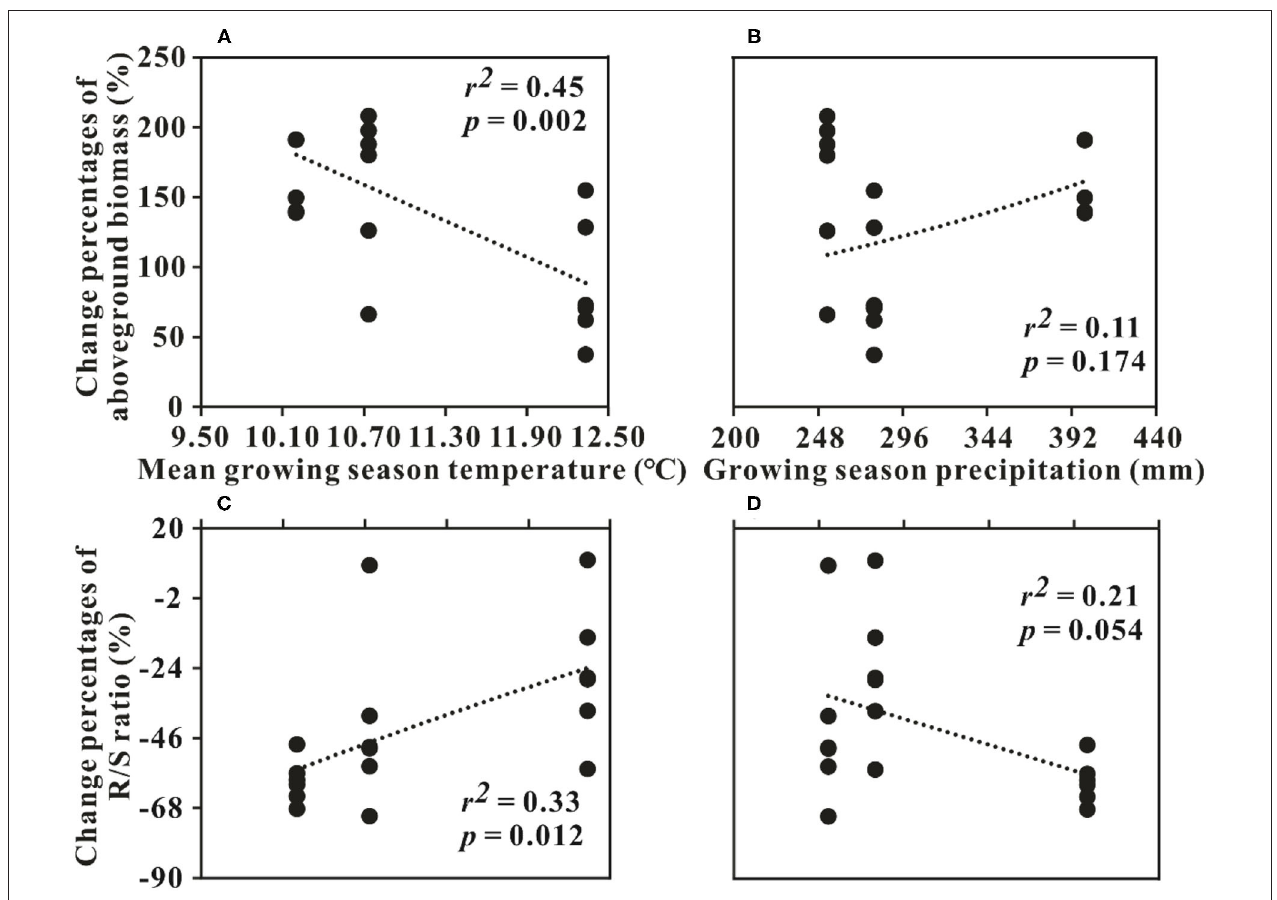
FIGURE 4 | Relationships between the changes in aboveground biomass, (A,B) R/S ratio; (C,D) and climatic factors in the restored grassland around Qinghai Lake Basin. R/S ratio, the ratio of root and